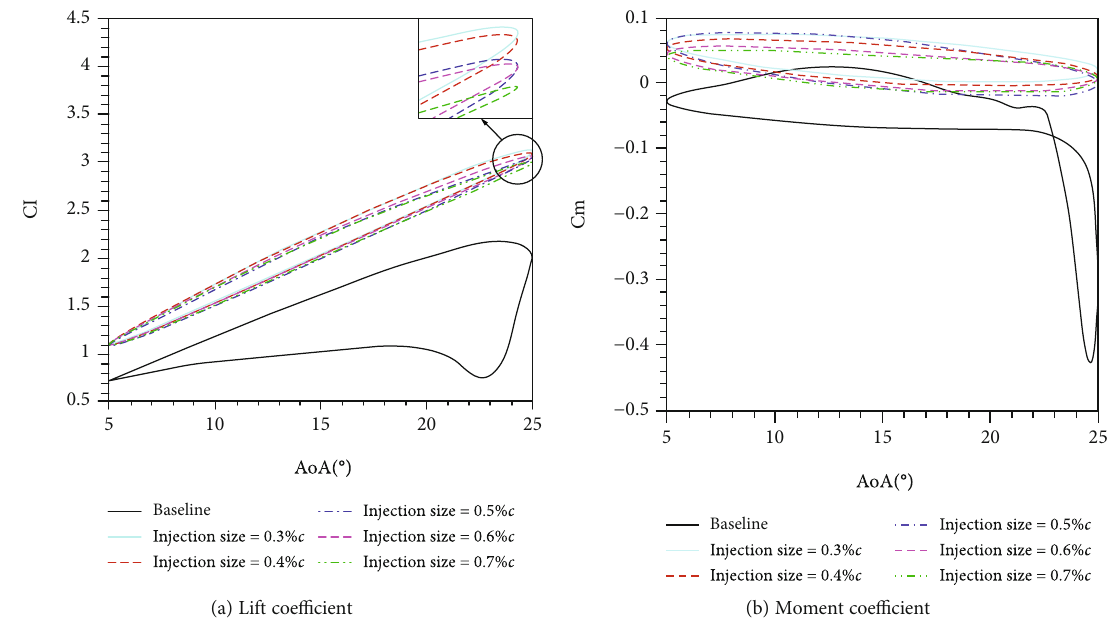
Figure 15: Hysteresis curves of lift and moment coe ffi cients with the AoA under di ff erent injection slot sizes.